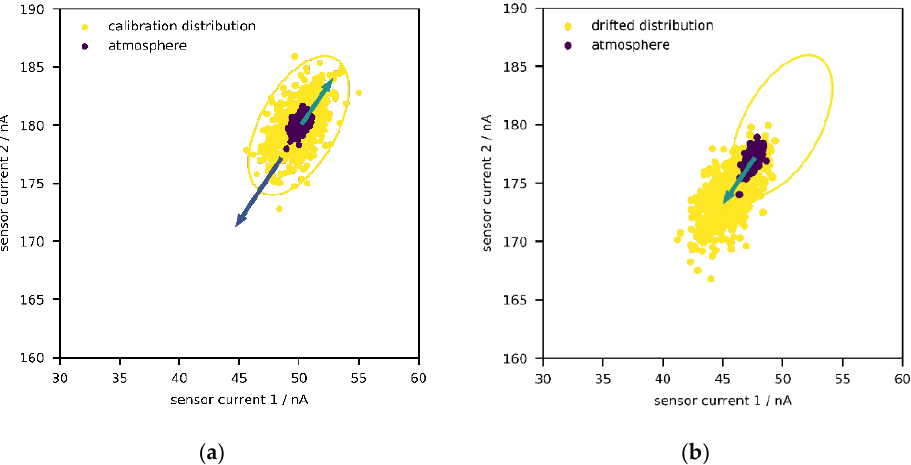
Figure 5. Distribution of sensor currents for a system consisting of two sensors. ( a ) Direction of aging drift (blue) is opposite to trajectory of atmosphere (green); trajectories are along largest expansion of the envelope. Signals decrease due to aging, but atmospheric amount fractions increase. Thus, the aging process is masked. ( b ) After some time, the generated signal intensities will be low enough to be outside the envelope and identified.